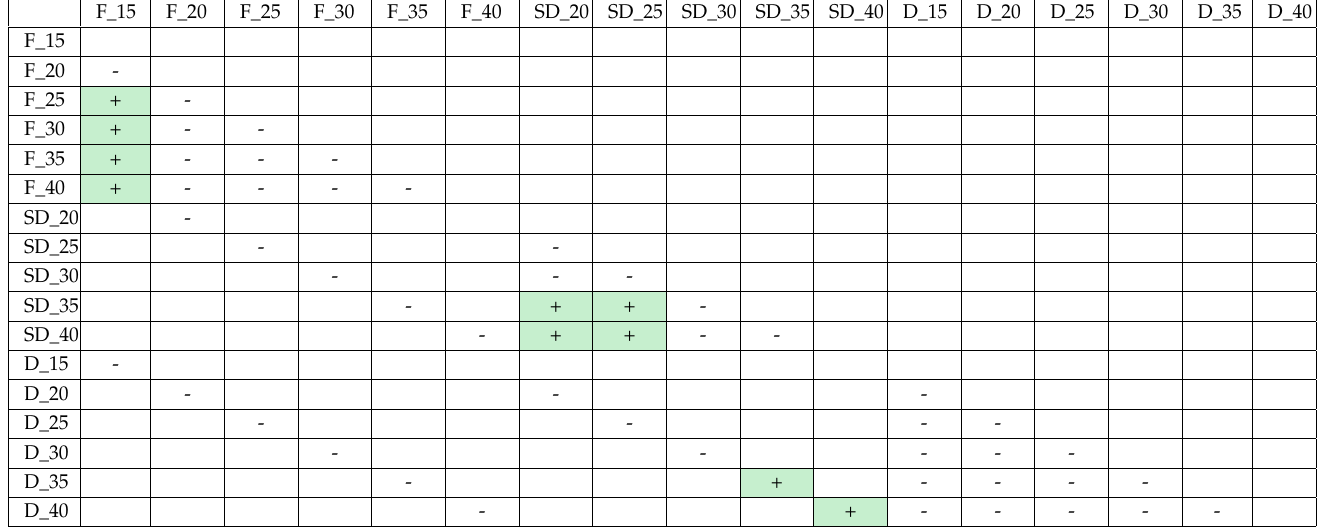
Table A2. WHC (volume based) significance − 1 kPa, plus (+) and green background indicates significant differences, minus (-) indicates statistically insignificant